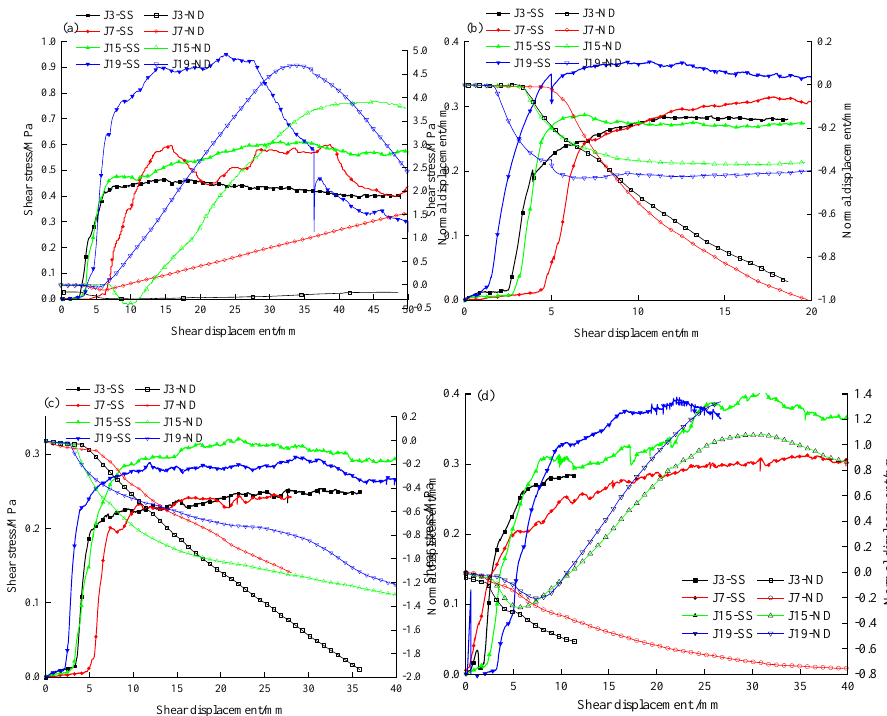
Figure 3: Shear stress (SS) and normal displacement (ND) versus shear displacement (SD) curves under normal stress of 0.5 MPa: (a) without filling; (b) semi-solid soil; (c) plasticized soil; and (d) Liquid soil.